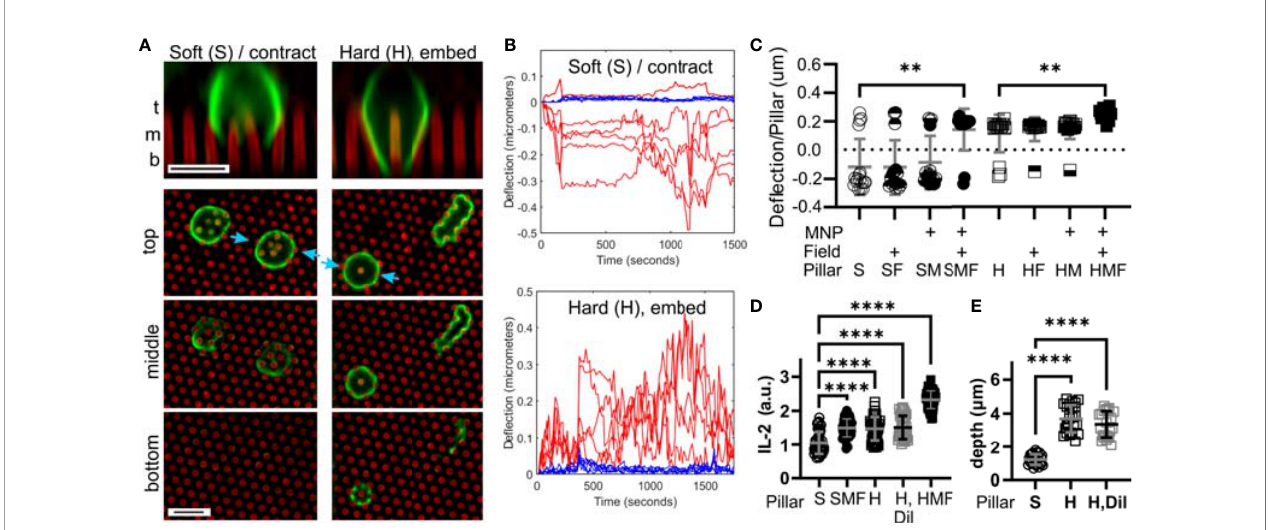
FIGURE 2 | T cells respond to the microscale rigidity of micropillar arrays. (A) Comparison of mouse naïve CD4 + T cell interaction with arrays made of Soft (S) or Hard (H) PDMS. Focal planes representing the top, middle, and bottom of the arrays are shown, along with vertical projections collected at sites indicated by blue arrows. Cells were fi xed 25 minutes after seeding, and were labeled with an anti-CD45 antibody (green). Pillars are shown in red. Scale bars = 5 µm. (B) Example trajectories illustrating de fl ections associated with a single cell on either Soft (S) or Hard (H) arrays. Red traces report de fl ections of individual pillars being manipulated by the cell, while blue traces illustrate movement of background pillars. These traces were derived from Movies S1 , S2 . De fl ections towards the edge of the cell were assigned a positive sign, while those towards the cell center were negative. (C) Comparison of pillar de fl ections as a function of array formulation and magnetic fi eld manipulation. Each data point reports the average de fl ection of all pillars underlying one cell. Data were compared using Kruskal-Wallis test, and only comparisons within a PDMS formulation are indicated; additional comparisons are discussed in the main text. Bars represent mean ± s.d., representing at least 15 cells per condition from 4 independent experiments. (D) Comparison of IL-2 secretion. Each data point represents one cell. Bars are mean ± s.d., representing at least 35 cells per condition from 3 independent experiments. (E) Cell penetration depth into the pillar arrays, measured by microscopy of cell morphology. Each data point represent one cell. Bars are mean ± s.d., representing at least 22 cells per condition from 3 independent experiments. Data were analyzed by ANOVA. For all analyses, **P < 0.01, ****P <